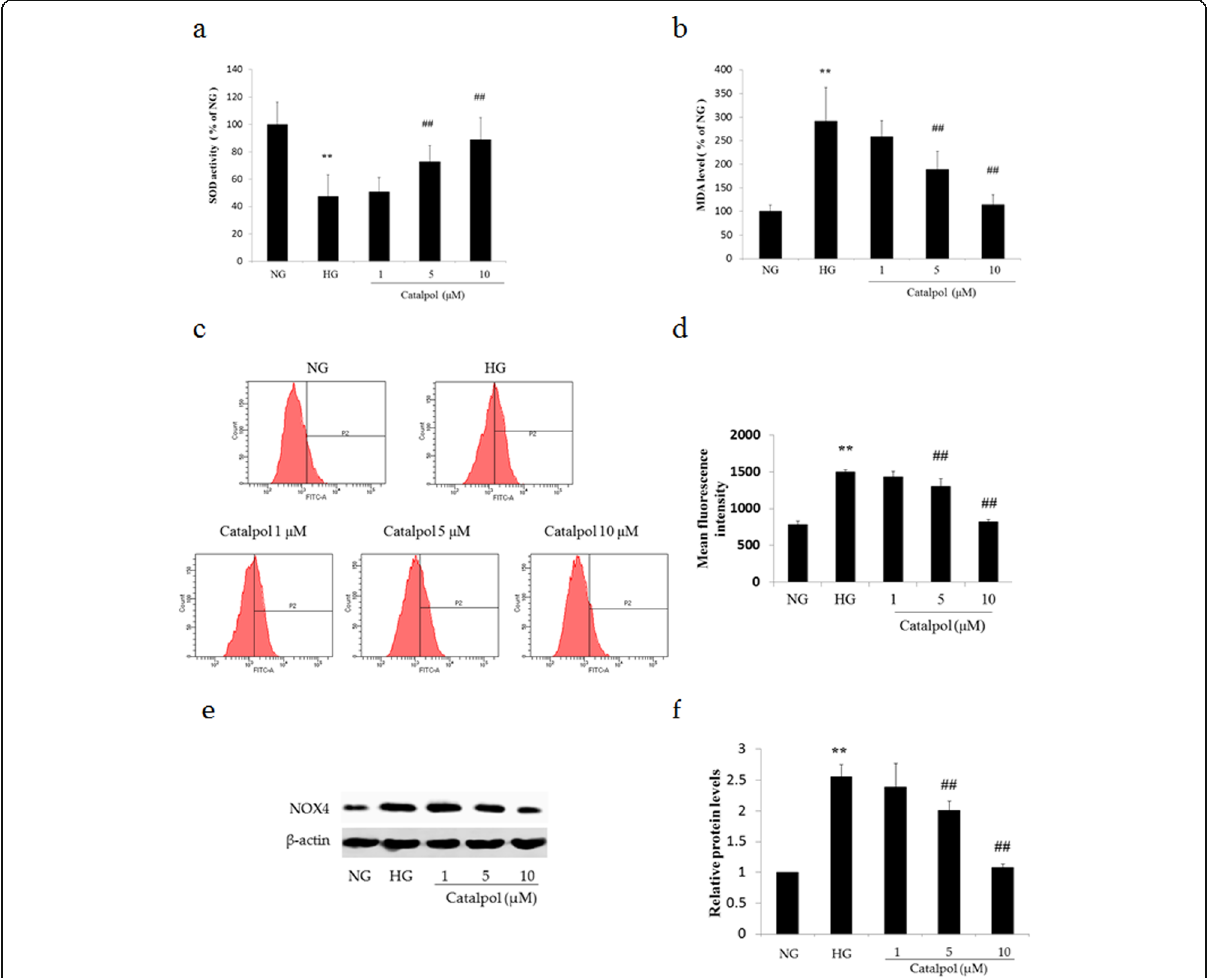
Fig. 3 The antioxidant effect of catalpol on HG-induced podocyte injury. a The activity of SOD ( n =6). b The level of MDA ( n =6). c The ROS content of podocytes sorted by flow cytometry. d Histogram of the ROS content of podocytes ( n =3). e NOX4 detection in podocytes by western blotting. f Histogram of NOX4 expression relative to β -actin ( n =3). Data are presented as the mean±SD. ** p <0.01 vs NG, ## p <0.01 vs